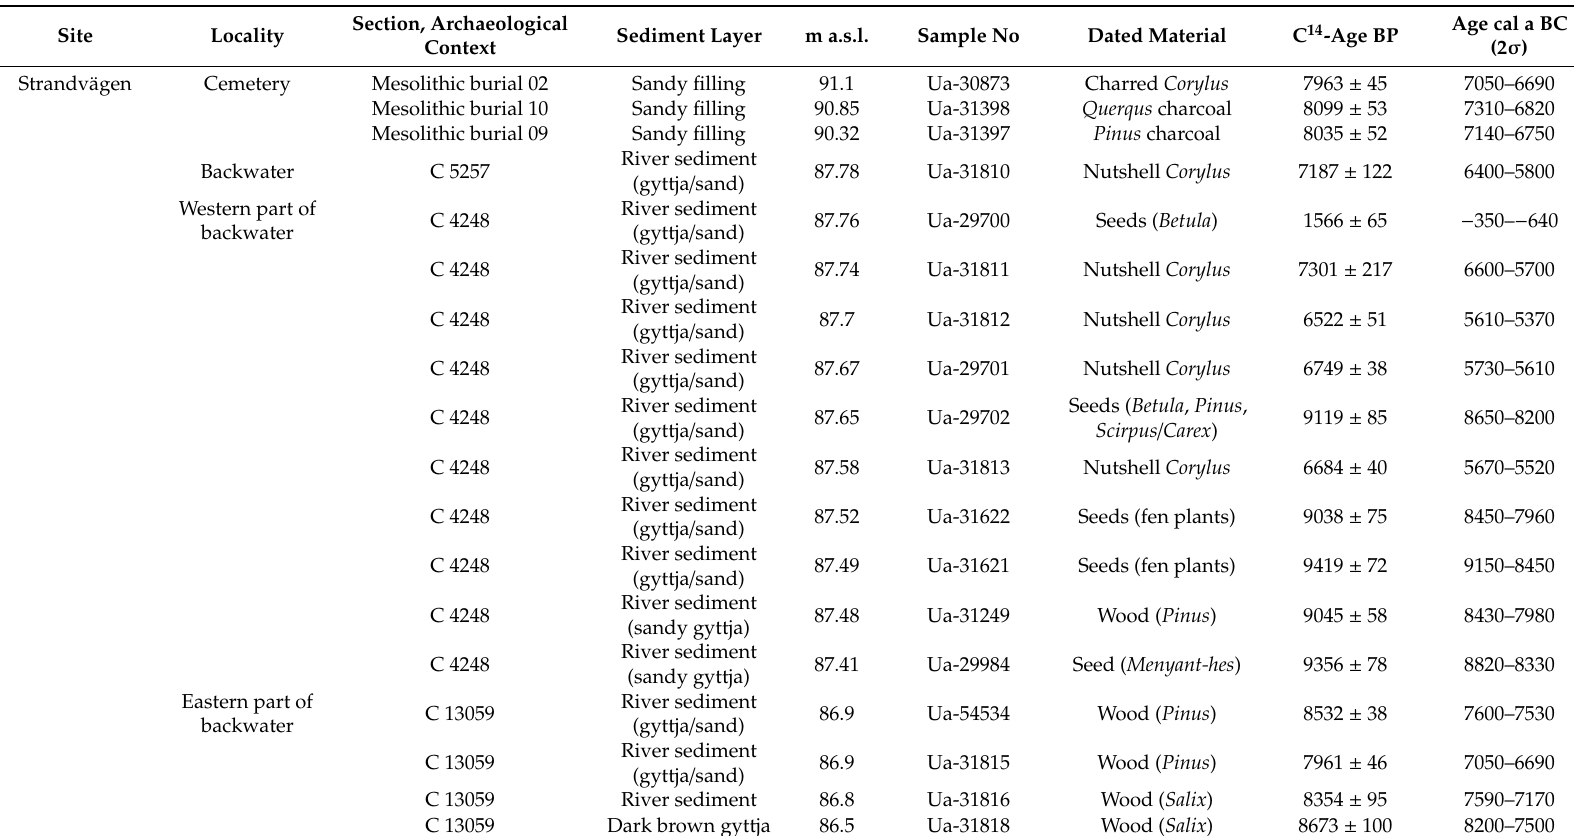
Table 2. 14 C dates from Holocene stratigraphical sequences in Motala (Strandvägen and Kanaljorden). The 14 C ages were calibrated using the OxCal 4.2.4 software [43], and the INTCAL 13 calibration data set [44]. All dates relevant for stratigraphical interpretation are included. Several archaeological radiocarbon dates (over 200) are not included [58,59], and younger dates ( Corylus ) from section C 13059 are omitted but shown in